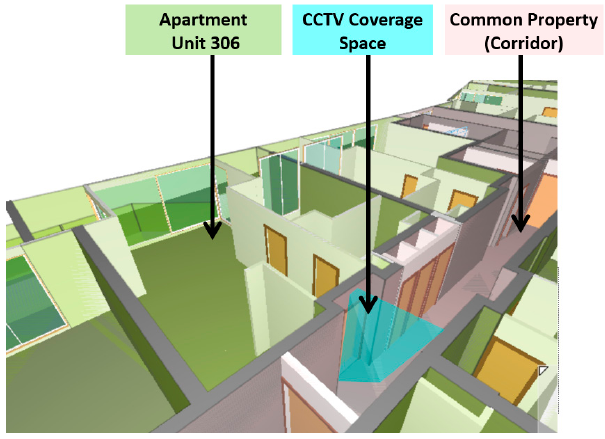
Figure 10. A CCTV coverage space represented inside the BIM model.